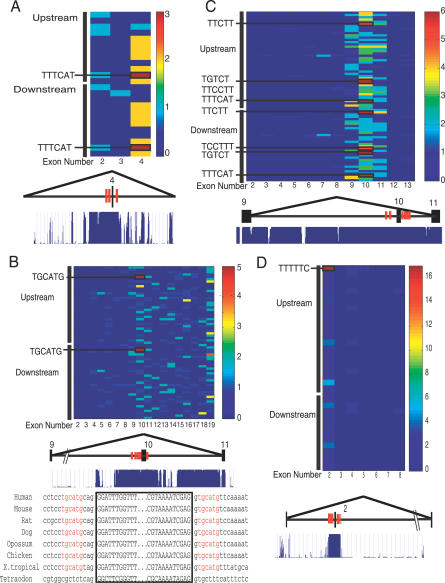
ISREs Proximal to Alternative Exons in Splicing Factors Resemble its RNA Binding SitesA total of 400 bases of intronic region flanking each internal exon were extracted for each splicing factor. Each box in the grid represents the total number of nonoverlapping occurrences of the conserved ISRE (either upstream ISRE or downstream ISRE) in the flanking intronic regions. ISREs that occur at least once in the flanks of at least one exon are retained in the grid. The exon–intron structure of selected exons are depicted below each grid. Tall vertical rectangles depict exons, and interconnecting lines represent introns; the line connecting nonadjacent exons represents alternative splicing of the middle exon. Red bars proximal to the alternative exon illustrates the ISRE. The level of conservation across multiple species (from the hg17 UCSC genome browser) is depicted below the exon.(A) Nova1: U149 (TTTCAT) and D150 (TTTCAT) are the most abundant ISREs in the flanking intronic region of exon 4. The flanking intronic region of exon 4 has the highest sequence conservation across mammalian genomes among all flanking intronic regions in Nova1.
(B) FOX1: U25 (TGCATG) and D20 (TGCATG) are the most abundant ISREs in the flanking intronic region of exon 10 in FOX1. The flanking intronic region of FOX1 has the highest sequence conservation among all flanking intron regions in FOX1. The exon 10 sequence (boxed) and 15 bases of flanking intronic regions are depicted below the exon–intron structure of exons 9, 10, and 11. TGCATG sites (in red) are overlapping the 5′ss and 3′ss.(C) nPTB: exon 10 of nPTB has transcript evidence for alternative splicing, and contained highly abundant U26 (TTCTT), U121 (TGTCT), U122 (TTCCTT), U149 (TTTCAT), D21 (TTCCTT), D108 (TCCTTT), D115 (TGTCT) and D150 (TTTCAT).(D) hnRNP C: the flanking intronic regions of exon 2 of hnRNP C contains 17 copies of TTTTT (an element in U4), and is the most highly conserved among the intronic regions in hnRNP C.